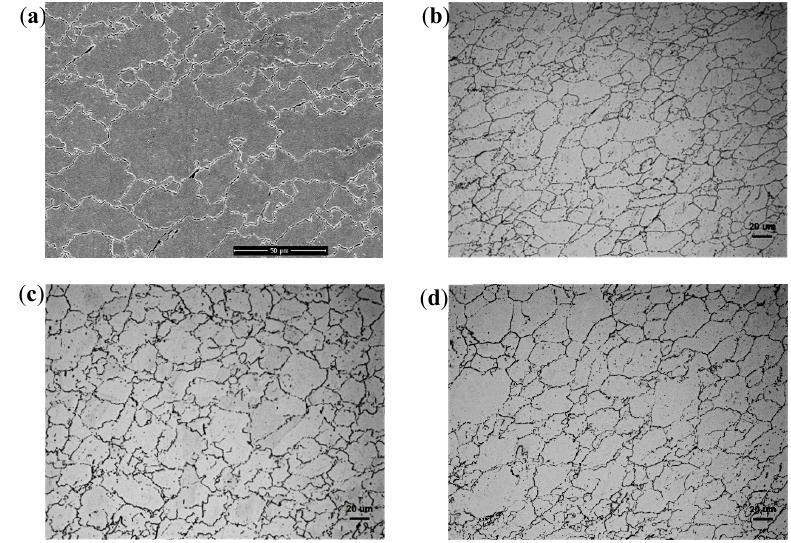
Figure 8. The thermo-mechanically affected zone (TMAZ) microstructure of specimens ( a ) No.1, ( b ) No.2, ( c ) No.3, and ( d )